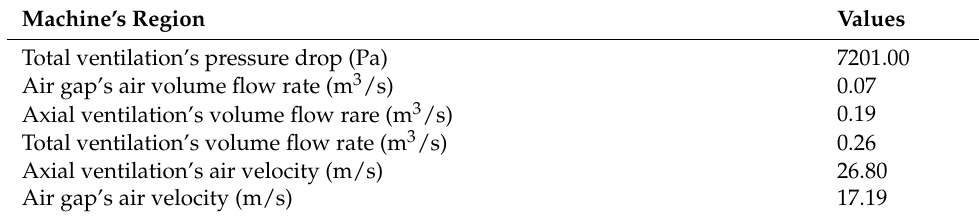
Figure 9. Analytical proposed LPTN model of 225 kW HSPMSM with FACAVS. Table 5. Calculated air coolant′s parameters.